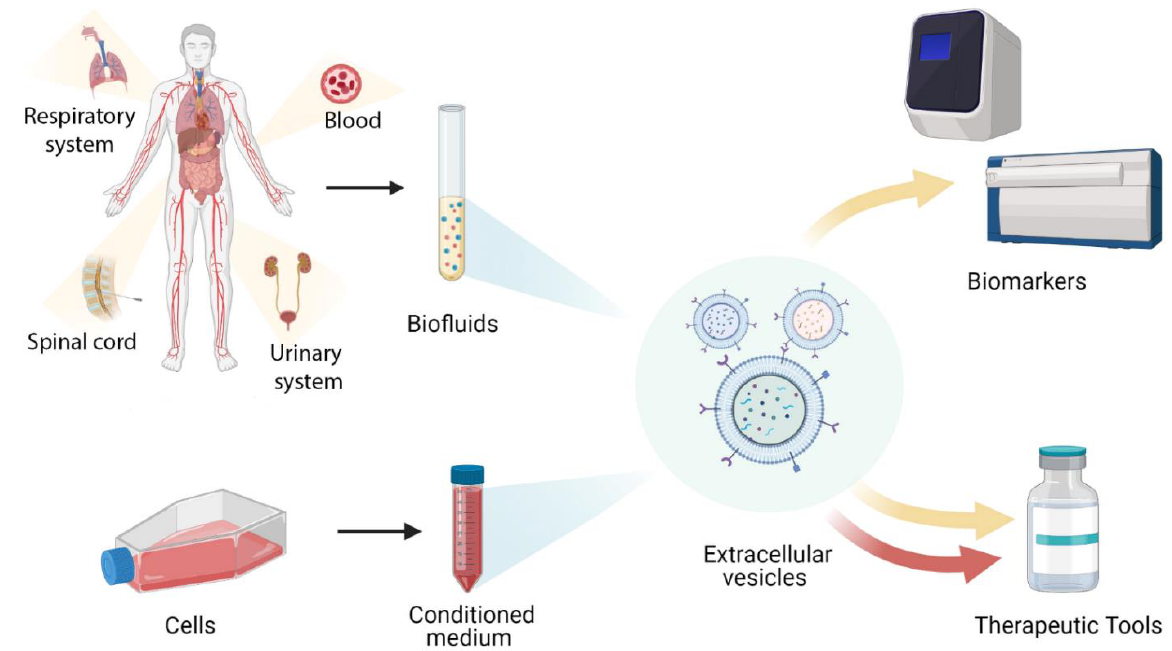
Figure 1. Schematics depicting the possible use of Extracellular Vesicles as biomarkers or therapeutics in both pre-clinic and clinic applications.